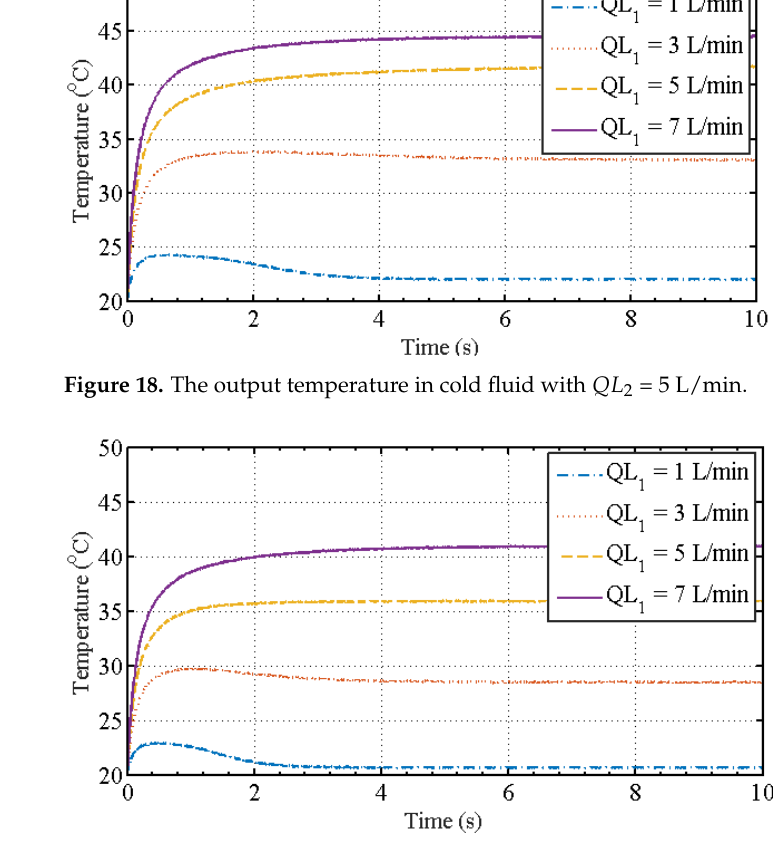
Figure 19. The output temperature in cold fluid with QL 2 = 7 L/min.